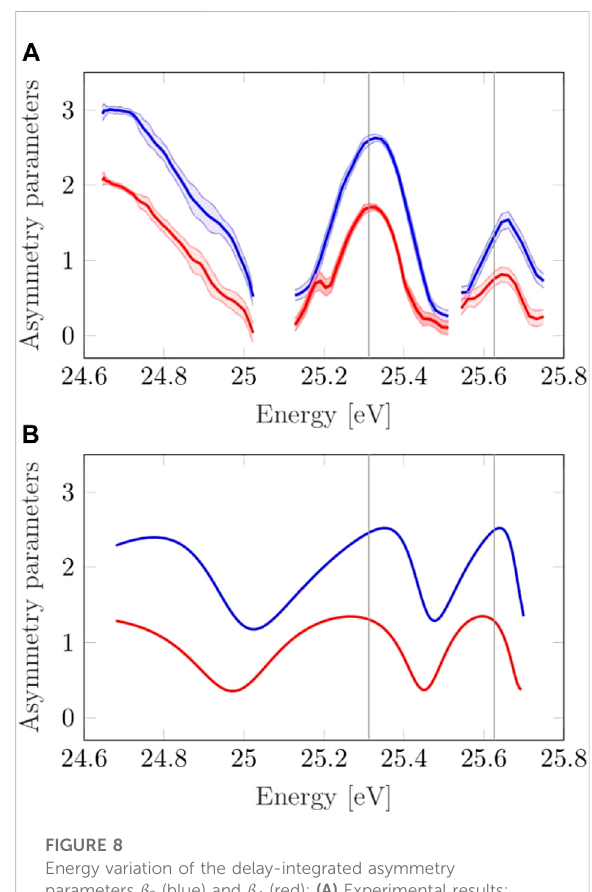
Energy variation of the delay-integrated asymmetry parameters β 2 (blue) and β 4 (red); (A) Experimental results; (B) Theoretical calculations obtained at a given dressing fi eld wavelength, equal to 782 nm. The grey lines indicate the energies corresponding to the 1 snp 1 P 1 resonances with n =